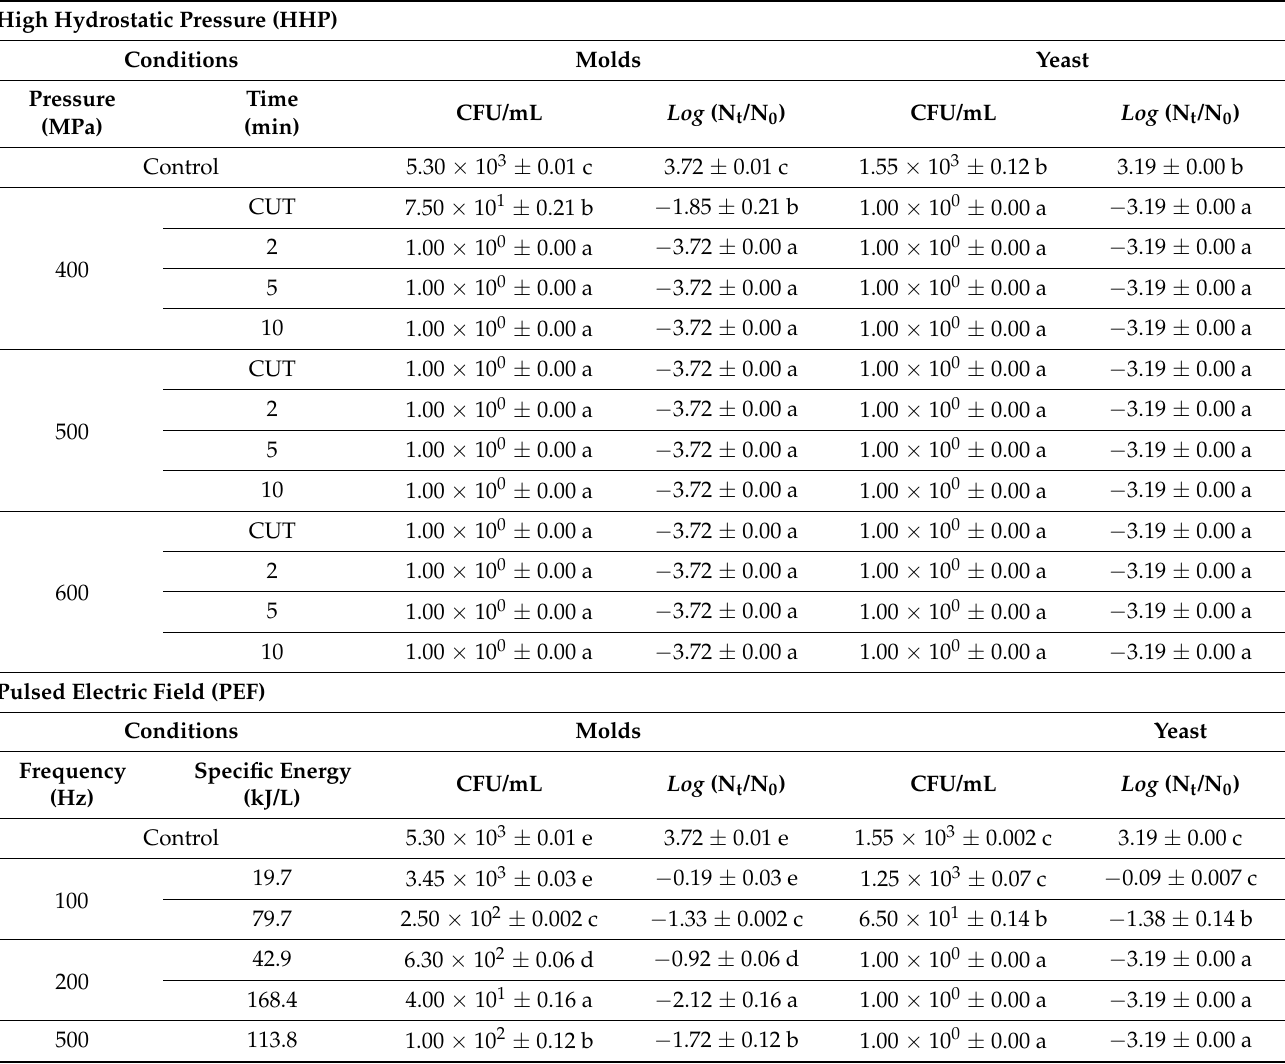
Table 1. Effect of HHP and PEF treatments on log reduction of molds and yeast of black/red raspberry